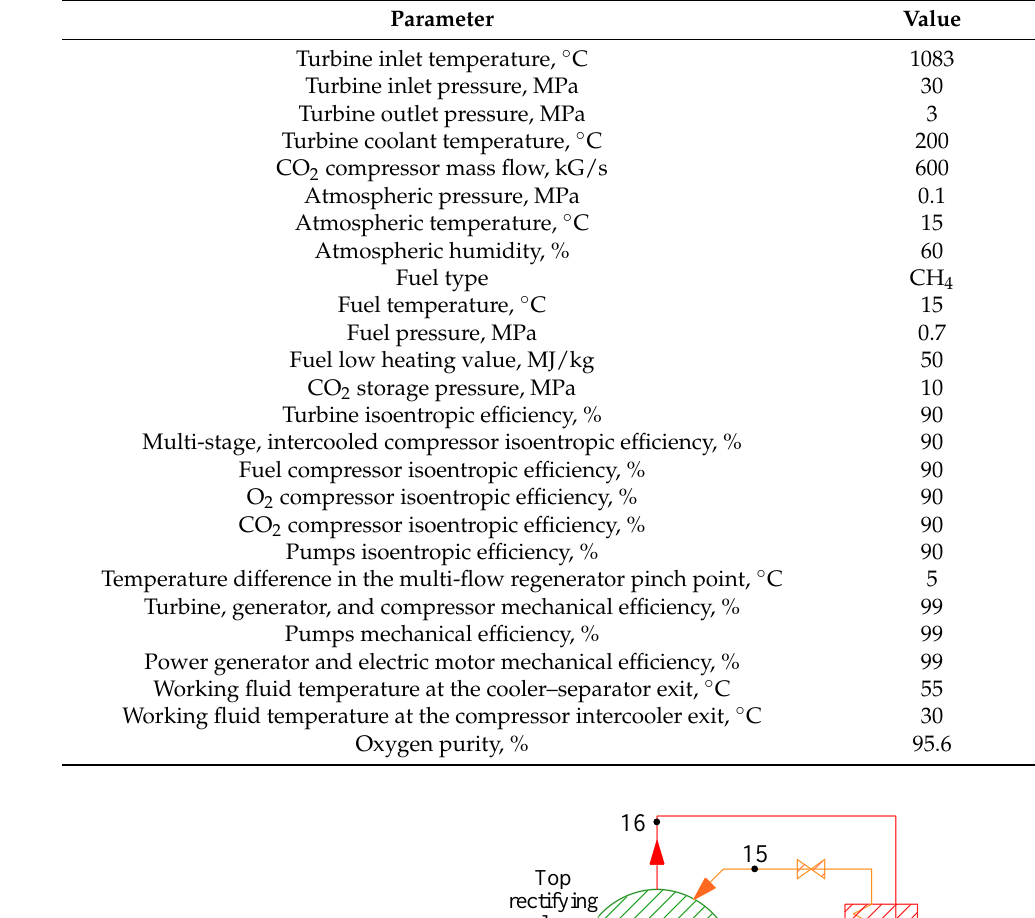
Table 1. Cycle simulation input data.